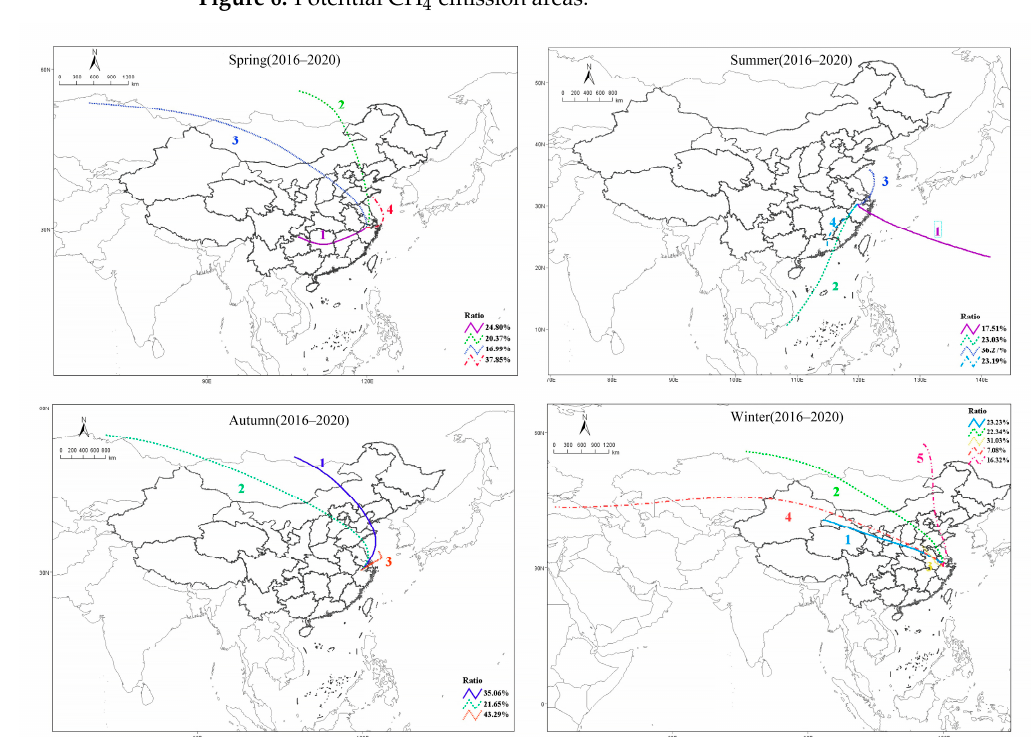
4 emission areas.